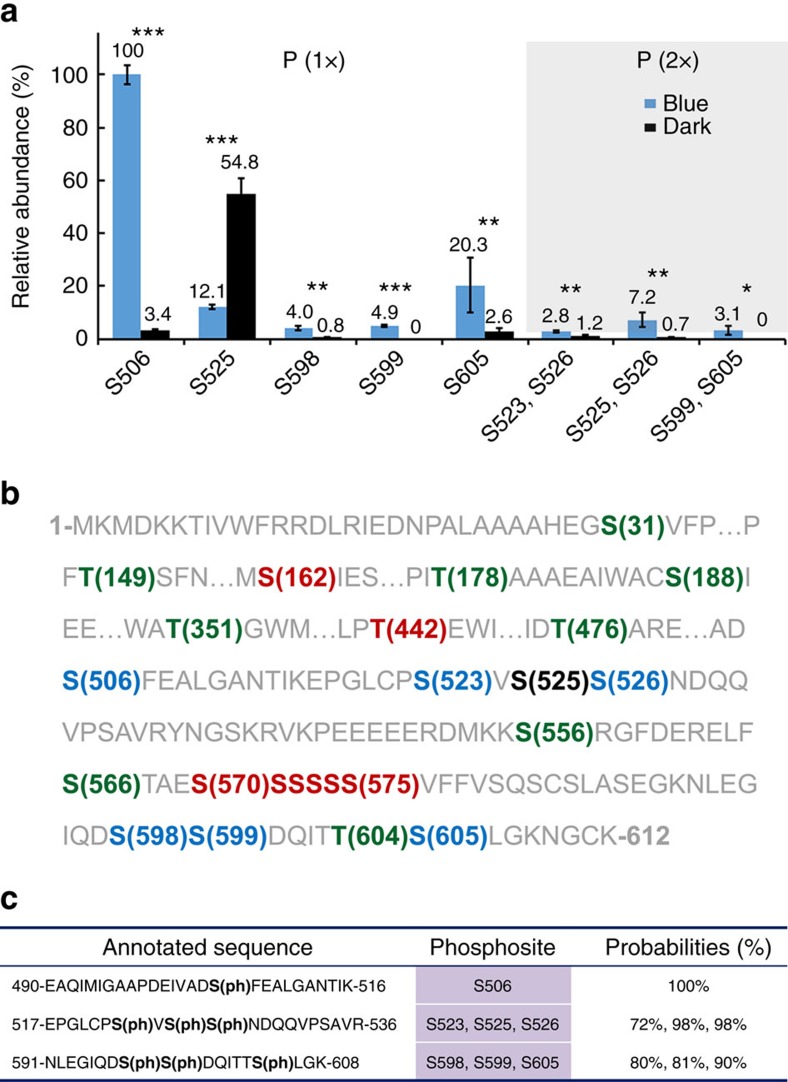
MS analyses of the blue light-dependent in vivo phosphosites of CRY2.(a) The relative abundance of major phosphopeptides detected in GFP-CRY2 purified from etiolated (Dark) seedlings exposed to blue light for 30 min (Blue: 30 μmol m−2 s−1) that are detected by at least three algorithms in at least three independent MS experiments. The intensity of the indicated phosphopeptide containing the respective phosphosite was determined by the label-free MS1 peak area of each phosphopeptide performed with Maxquant. Data represent three biological replicates, each contains both the light-treated samples (Blue) and the dark control (Black). The LFQ intensity of phosphopeptide derived from MaxQuant was normalized against the LFQ intensity of the GFP-CRY2 input, and converted to relative abundance (numbers shown on the top of each bar) by dividing with the mean (n=3) of the most abundant phosphopeptide (S506) detected, which was set to 100%. The s.d. are shown (n=3). The phosphopeptide exhibited significantly different abundance between dark and light conditions was indicated as *** (Student's t-test, P<0.001), ** (Student's t-test, P<0.01), or * (Student's t-test, P<0.05) on the top of bars. (b) Major and minor phosphosites of CRY2 (residues 1–612, with sequences containing no phosphosite omitted as indicated by …) detected in this study. The phosphosites of CRY2 detected by at least three experiments and recognizable by 3, 2 or 1 algorithms are denoted by blue, red or green colour, respectively. The blue light-repressed phosphosite (S525) is coloured by black. (c) Examples of phosphopeptides of CRY2 phosphorylated on the mono-phosphosite and tri-phosphosites. The maximum probability shown for each phosphosite is calculated by Andromeda algorithm integrated in MaxQuant.